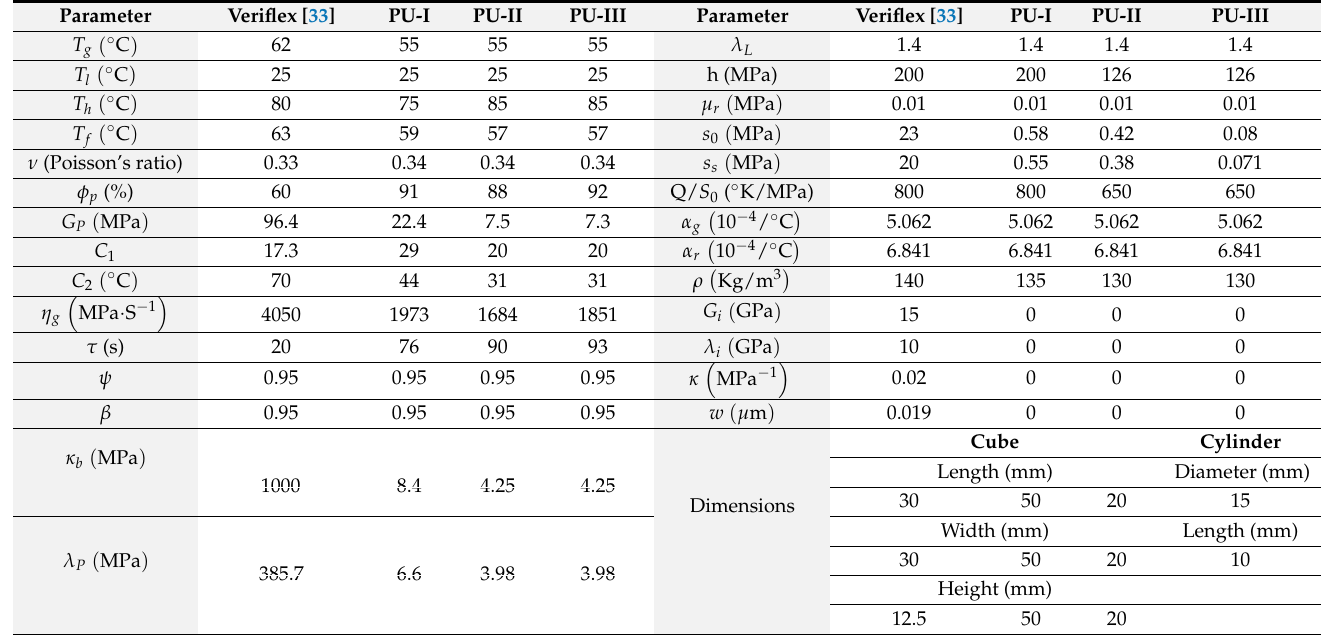
Table 2. Materials and geometrical parameters used for the simulation of SMP foams in this